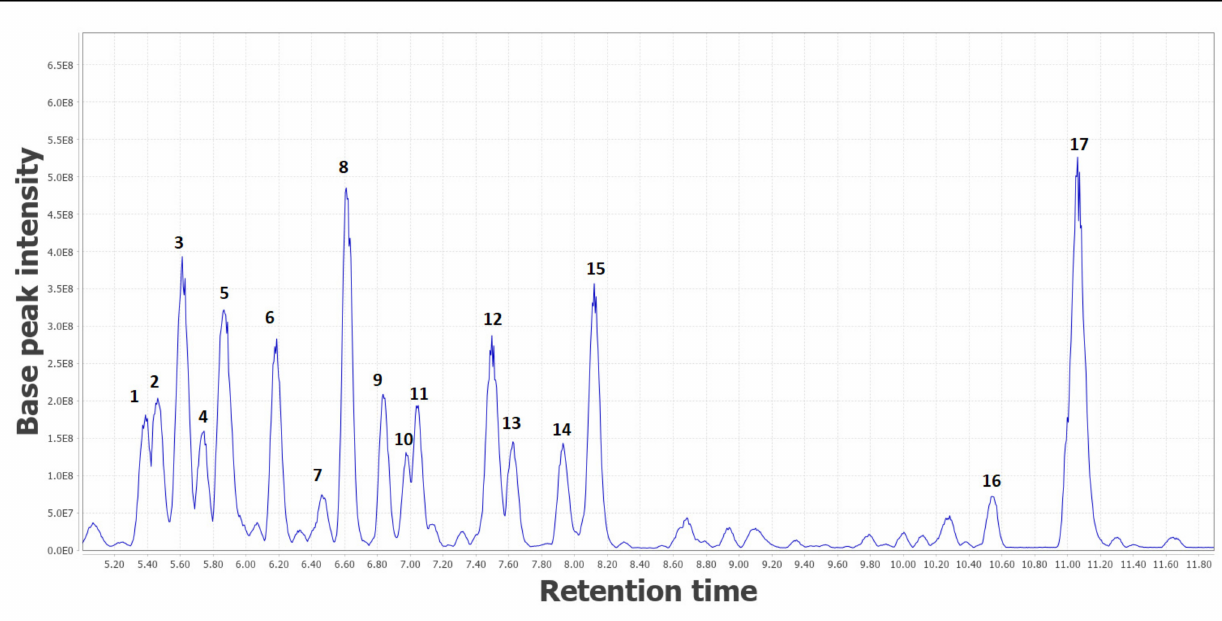
Figure 1. Total ion chromatogram (TIC) in negative ion mode of the rhizome extract. The number above each peak represents the peak numbers, corresponding to the peak numbers in Table